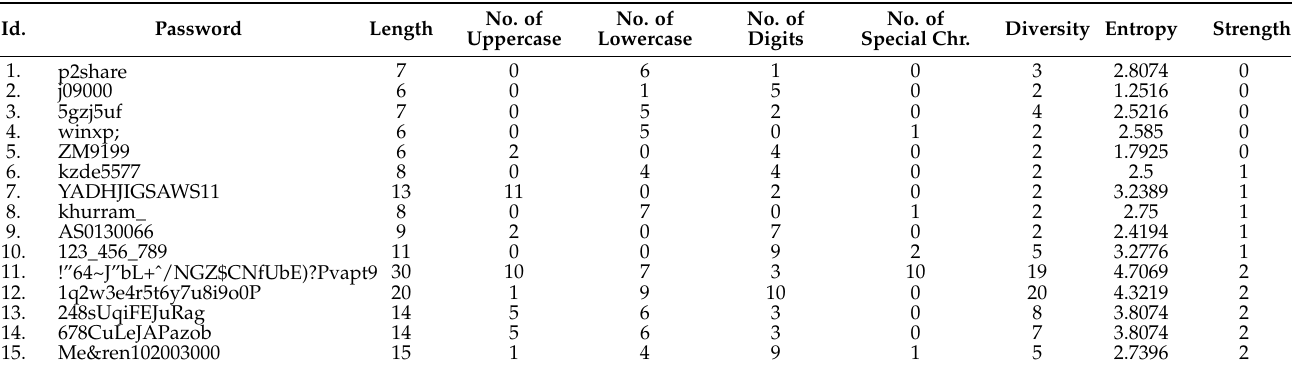
Table 3. A snapshot of the training password strength